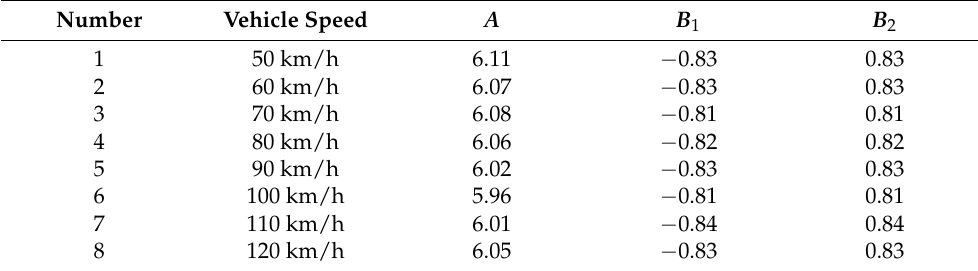
Table 4. Boundary parameters at different